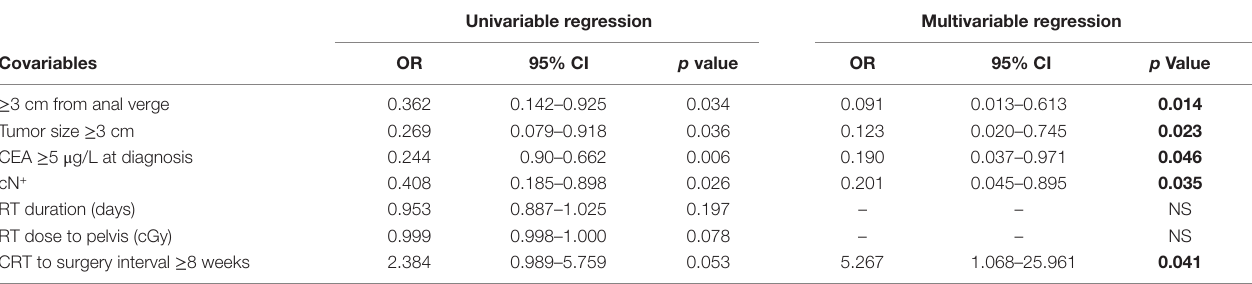
TaBle 4 | Predictors of complete response to chemoradiation.